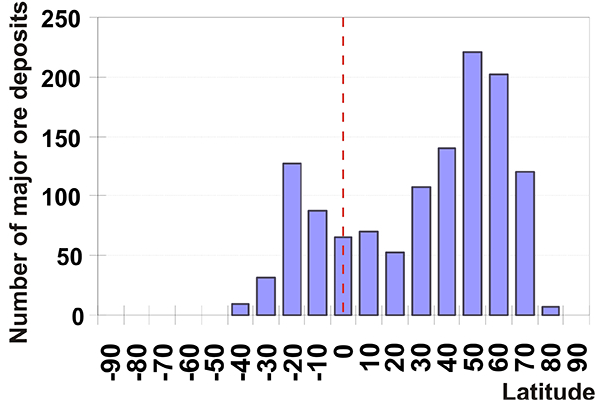
Fig. 8. The distribution of the major and super major ore deposit number over latitudes (bar chart). The horizontal axis shows latitu- dinal belts (10 ◦ wide), vertical axis – number of deposits. The red dotted vertical line corresponds to the